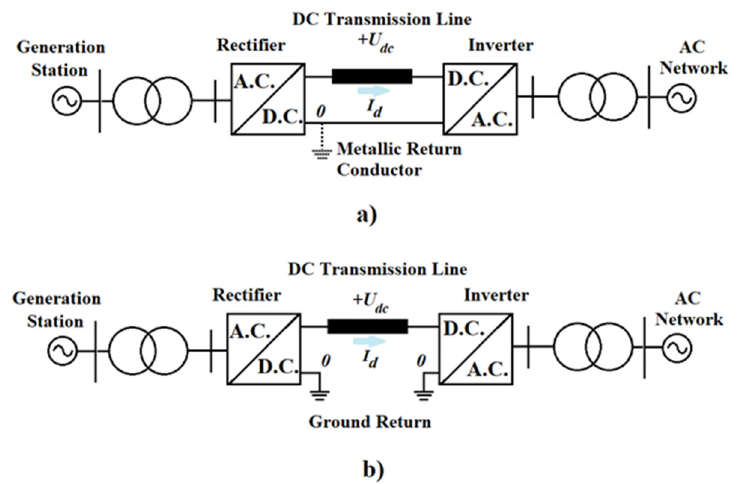
Figure 3. HVDC monopolar links: ( a ) metallic return conductor, ( b ) ground